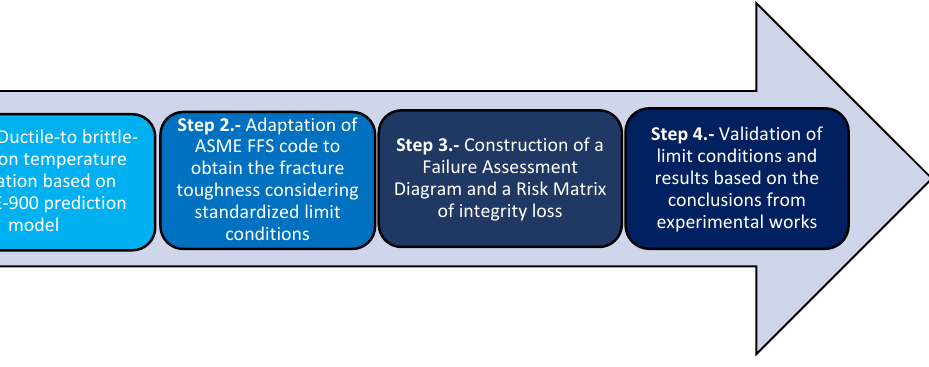
Figure 1. Methodology to perform mechanical integrity prognostics.